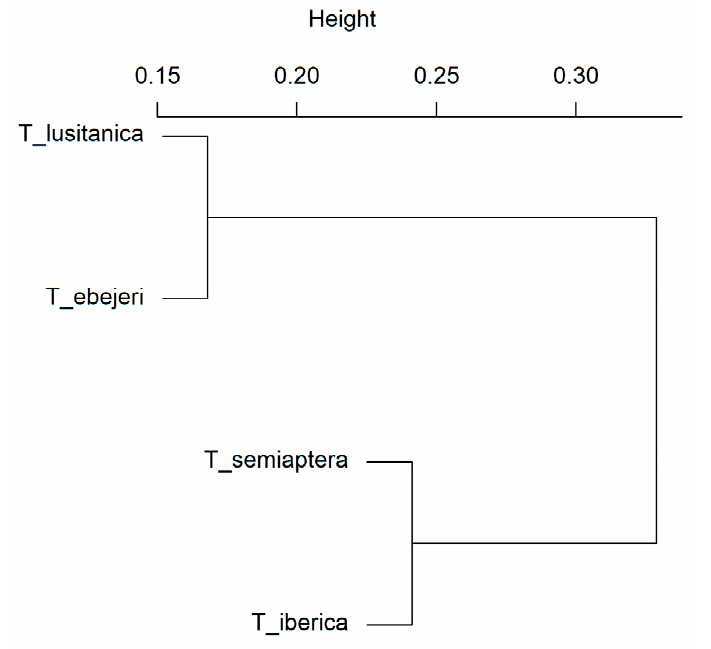
Figure 3. Hierarchical clustering dendrogram based on habitat suitability. Distance matrices were calculated as d = 1 − Spearman’s correlation. The average linkage method was implemented.